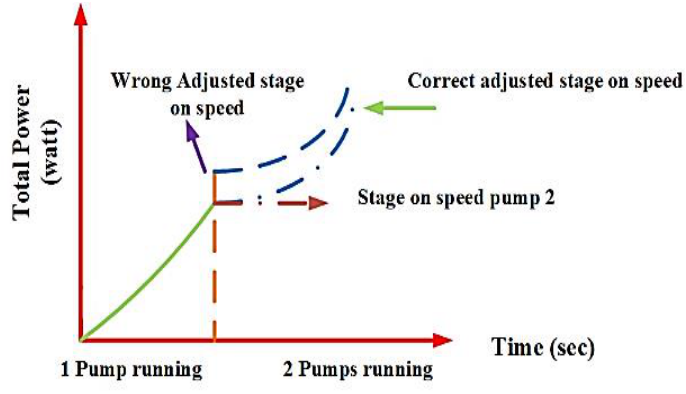
Figure 5. Total power consumption .